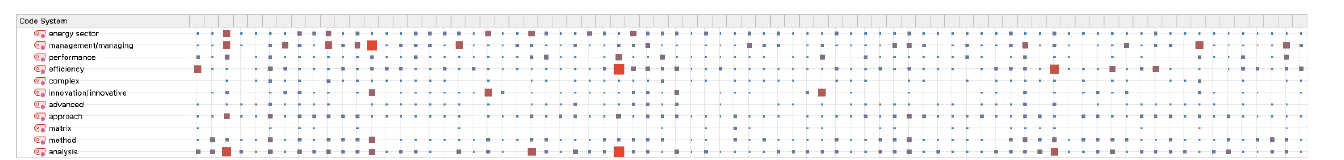
Figure A1. Code matrix browser (reflecting the distribution of codes across the analyzed texts; the rows are the codes applied with the use of a lexical search; the columns represent subsequent texts; due to the figure size the titles were not provided here). Source: own study.